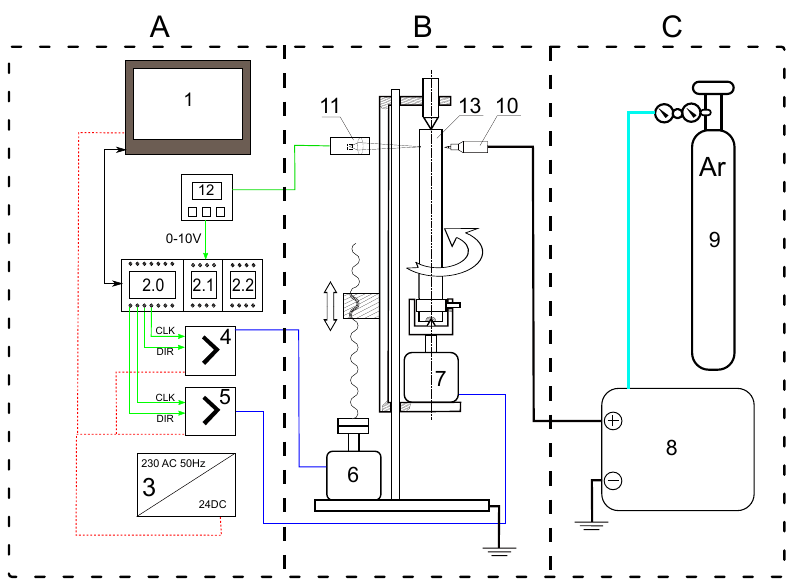
Figure 1. The experimental stand structure: 1, operational panel; 2.0, PLC main unit; 2.1, analog to digital module; 2.2, thermocouple module; 3, power supply; 4, 5, stepper motor drivers; 6, 7, stepper motors; 8, current source; 9, compressed argonium tank with pressure reduction unit; 10, welding grip with tungsten electrode; 11, measuring head of laser pirometer; 12, measuring transducer/amplifier of laser pirometer; 13, analysed